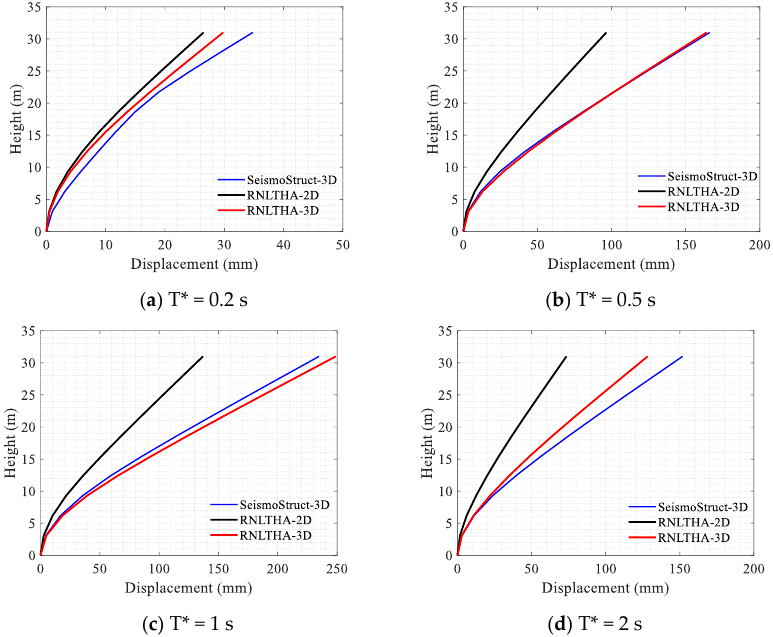
( b ) Comparison of displacements as obtained from Routine 1 and SeismoStruct. Figure 8. Comparison of the seismic demand as obtained from Routine 1 (RNLTHA-2D and 3D) with SeismoStruct-3D.